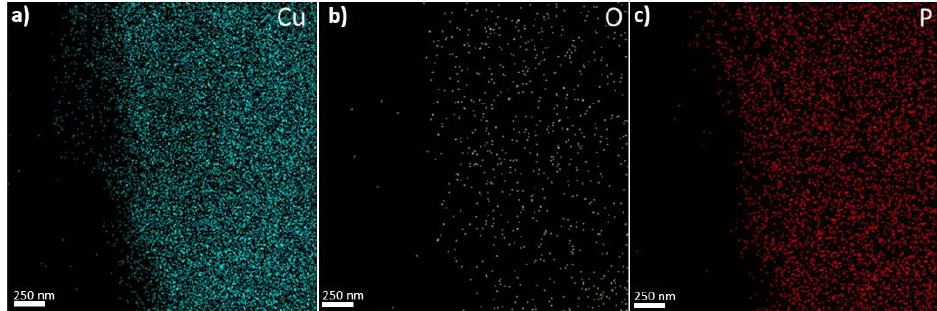
Figure 4. STEM color mapping image of the heterostructure to differentiate the elements ( a ) copper, ( b ) oxygen, and ( c ) phosphorous.